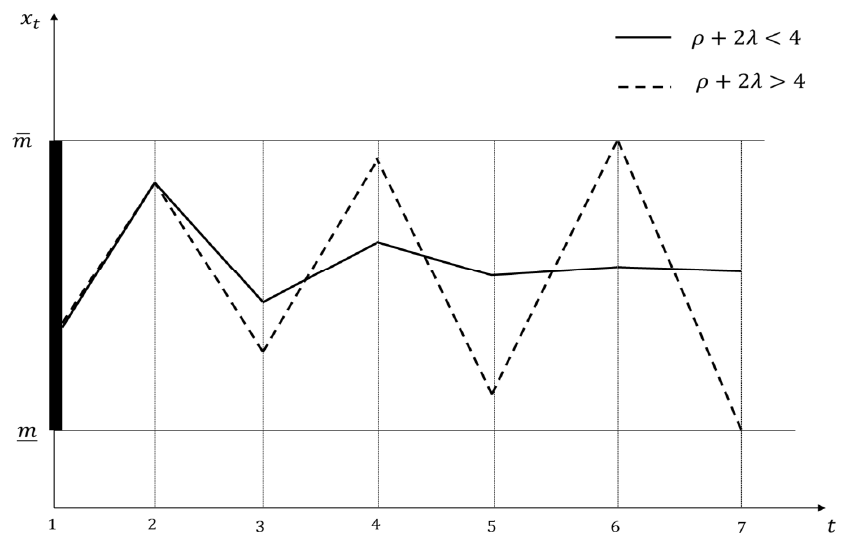
Figure 3. Decision paths with lower ( ρ + 2 λ < 4) and higher ( ρ + 2 λ > 4) impact of emotions and depreciation rate.